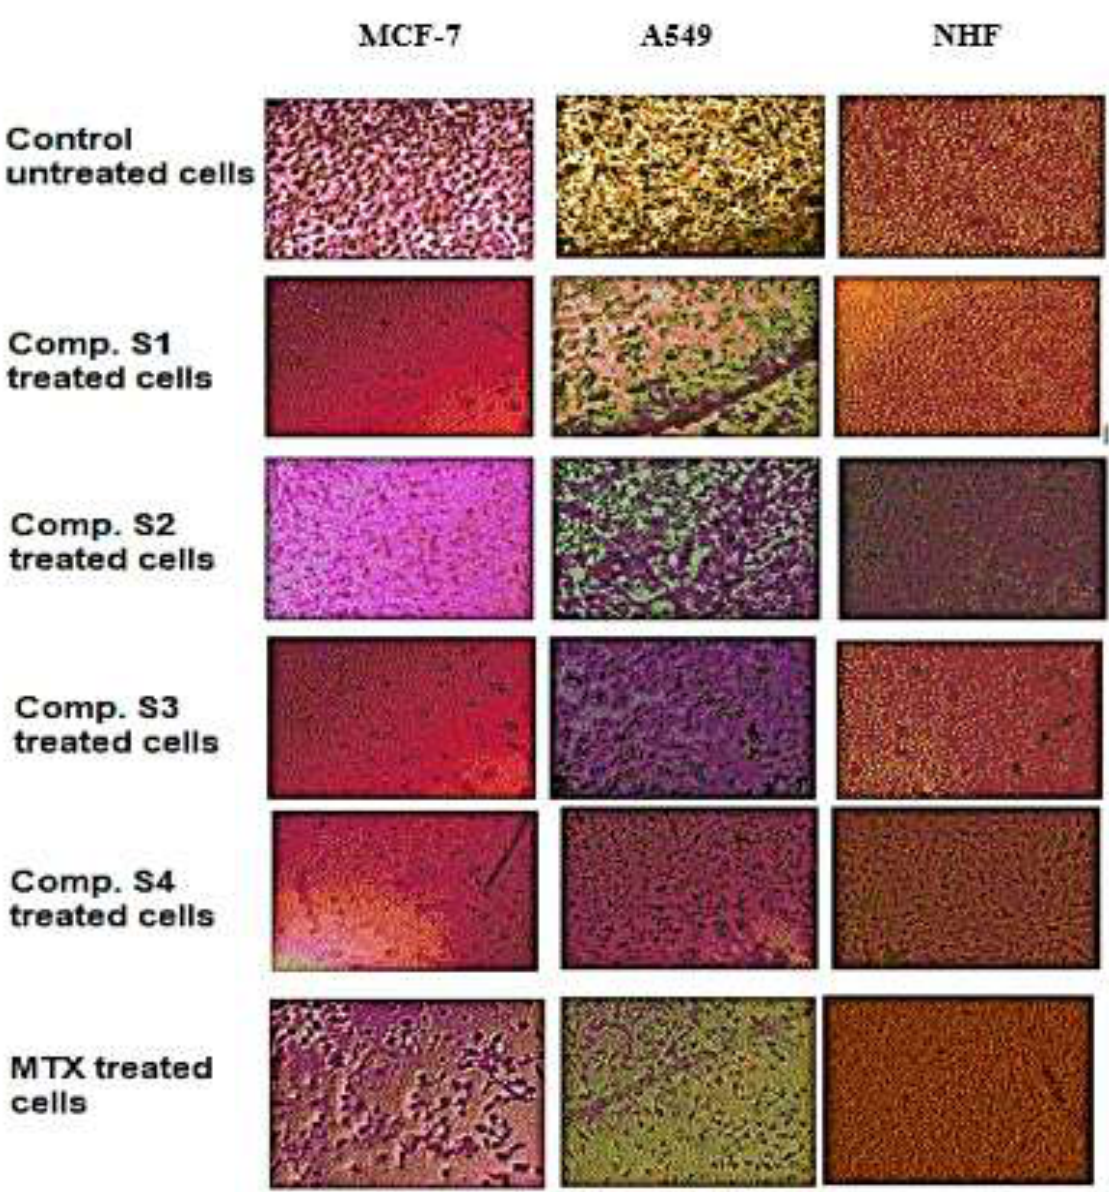
Figure 2. Morphology of the cell lines after treatment with compounds (S1-S4) at their IC 50 concentrations. The cells were observed under an inverted microscope at 100×